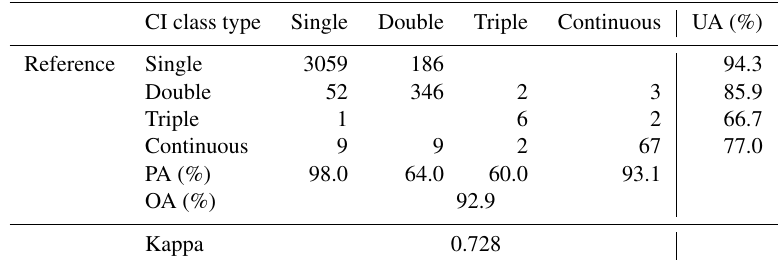
Table 2. Confusion matrices of